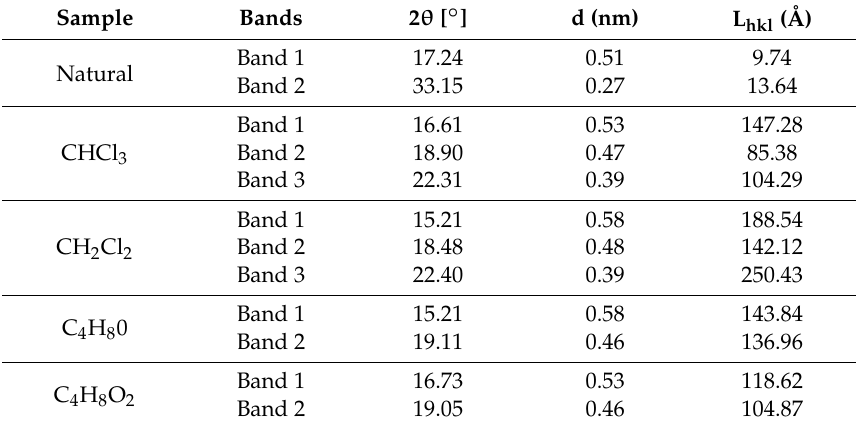
Table 2. Angular values of diffraction maxima and reticular spacing in the sample. Sample Bands